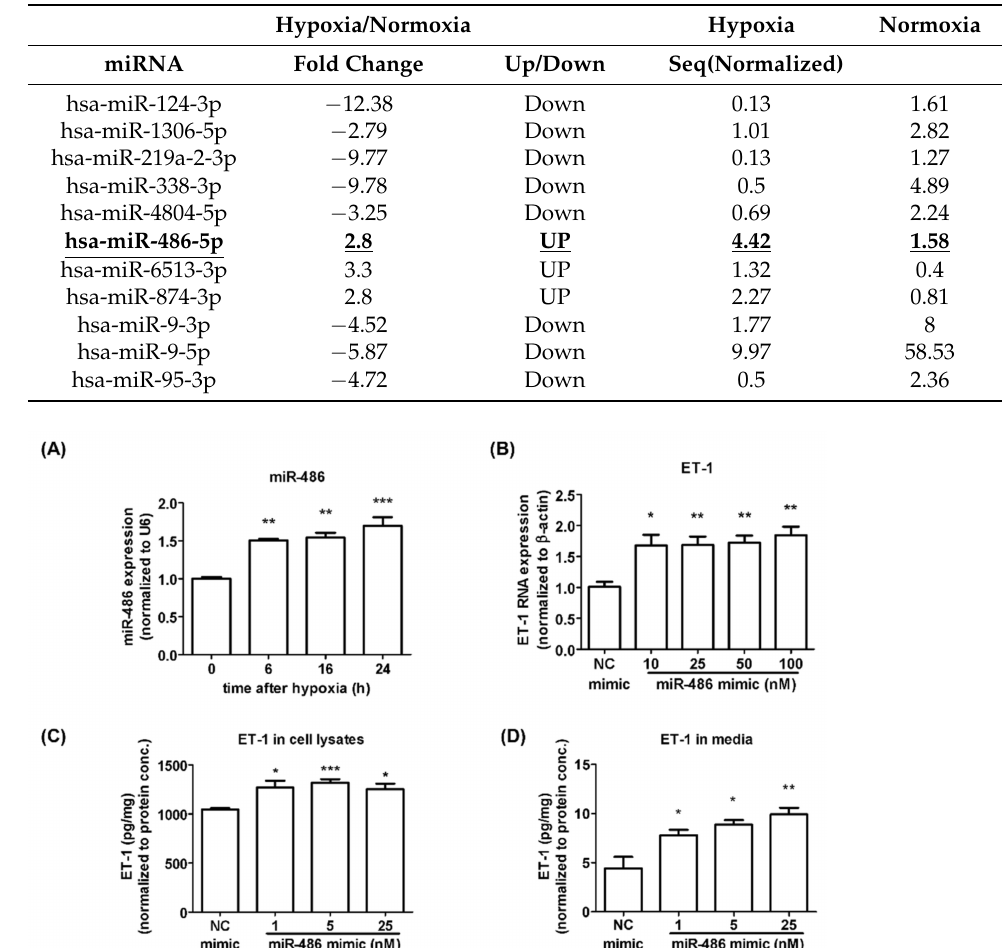
Figure 1. miR-486-5p increased the expression and secretion of ET-1 in HPASMCs. ( A ) After 6, 16, and 24 h of hypoxia treatment, the level of miR-486-5p was evaluated by qRT-PCR. HPASMCs were transfected with a miR-486-5p mimic or NC mimic, and the total RNA, cell lysates, and medium samples were collected after 48 h. ( B ) mRNA expression of ET-1 was determined by qRT-PCR. ( C ) ET-1 protein expression and ( D ) ET-1 secretion were determined by ELISA. Results are expressed as the means ± SEMs ( n ≥ 3). * p < 0.05, ** p < 0.01, and *** p < 0.001 compared with the T0 or NC mimic